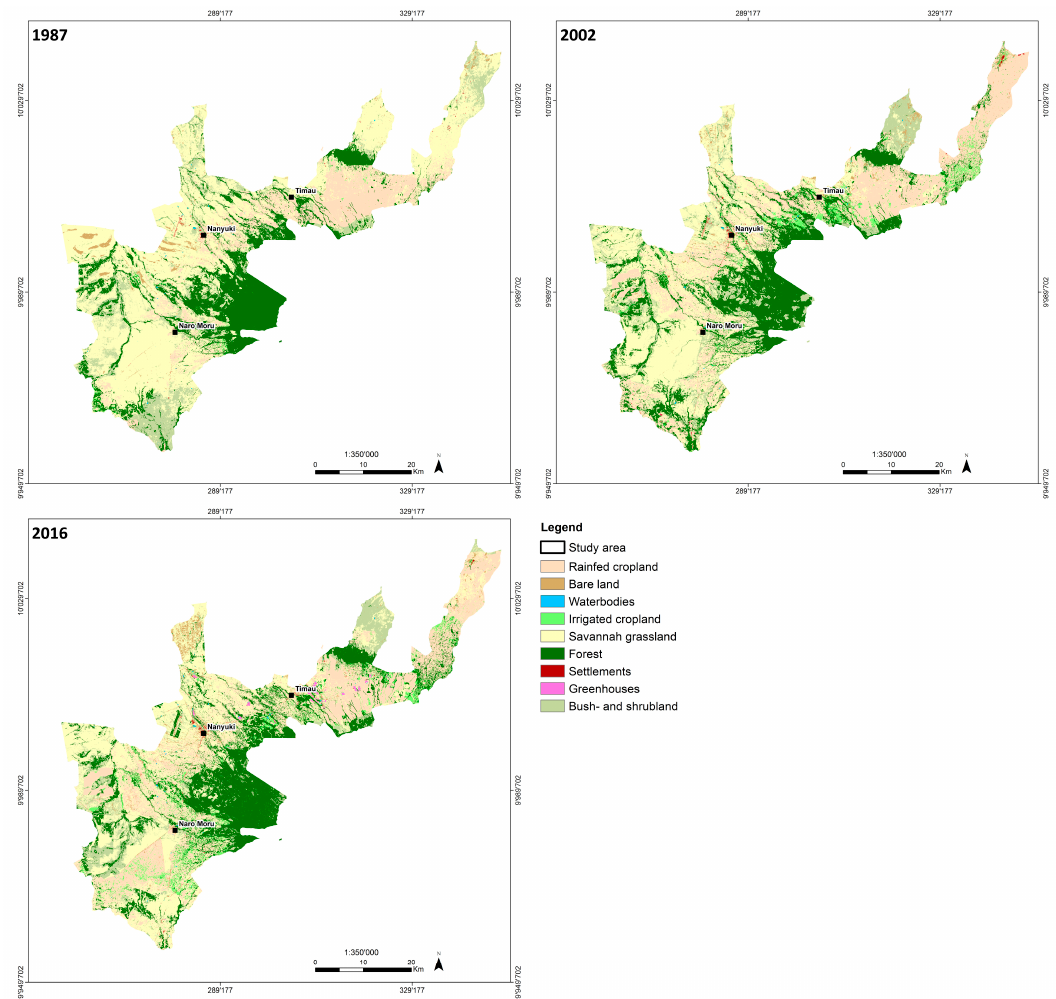
Figure 3. Land cover and land use classification maps of the study area around 1987, 2002, and 2016 (map projection: UTM 37S).